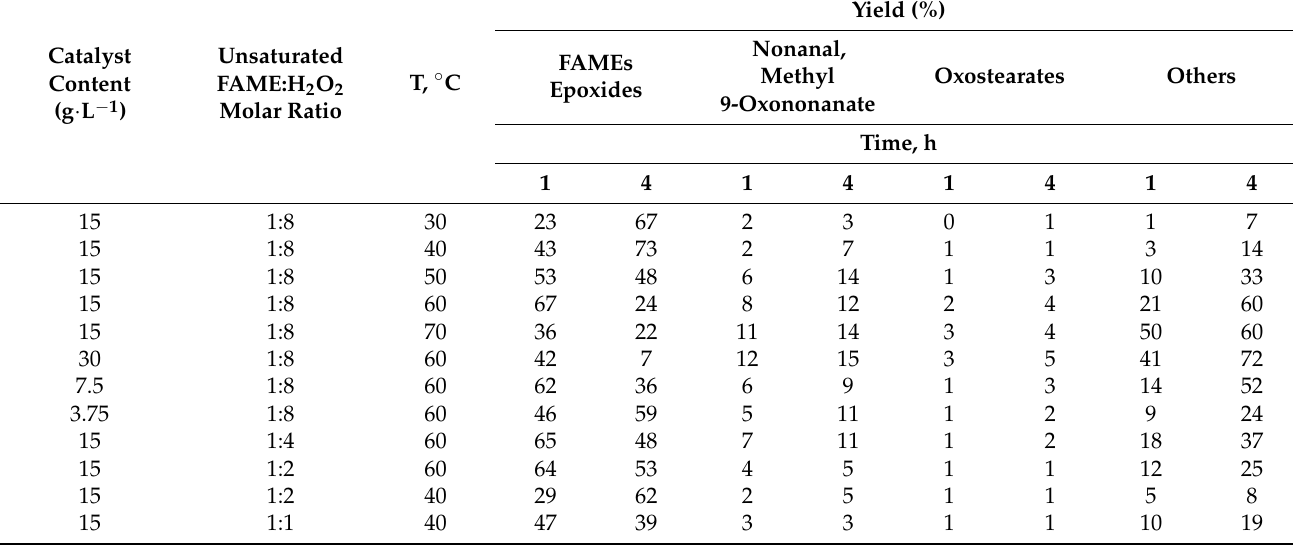
Table 4. The yields of the FAME epoxidation